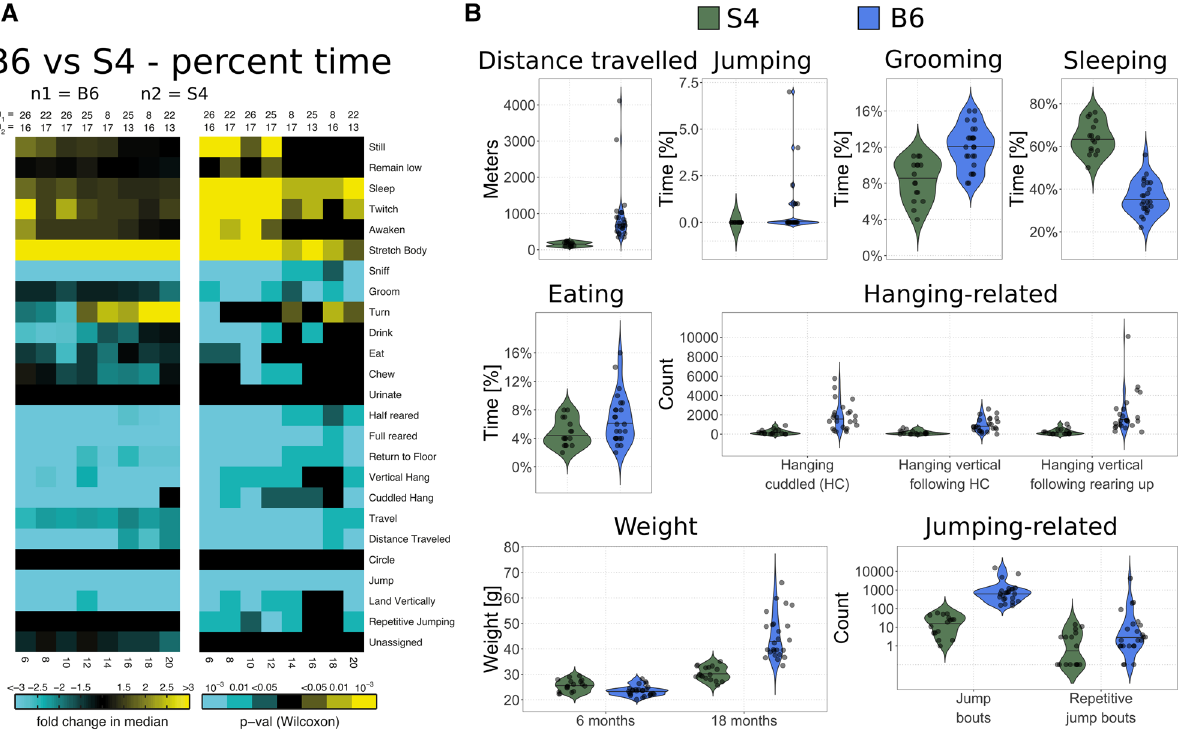
Figure 1. Home cage automated behavioral analysis. ( A ) Heat map showing statistical summary of longitudinal video monitoring analysis performed at 6, 8, 10, 12, 14, 16, 18, and 20 months of age on female mice. The number of mice at each timepoint is represented on the top of the heatmap as n1 for B6 and n2 for S4. Yellow tiles represent features present more in S4 than B6, whereas cyan tiles represent the opposite. The behavior “urinate” was not reliably scored so was disabled in this analysis. Otherwise, the heatmap displays all metrics studied. Two-tailed Wilcoxon rank sum (non-parametric) test. A p-value < 0.05 was considered significant. Multiple testing corrections were deemed unnecessary since nearly all metrics showed large differences. ( B ) Violin plots for select behaviors represent multiple metrics where B6 data where very spread out (tall and narrow violins) and the population is variable. In contrast, the violins in S4 are short and wide, indicating the population is very similar. The weight depicts data for 6 and 18 months, all other charts represent data at 6 months. Note the scale is log 10 for the “Jumping-related” panel. While both B6 and S4 demonstrate a wide range of jumping, the overall range in B6 is 100-fold higher than